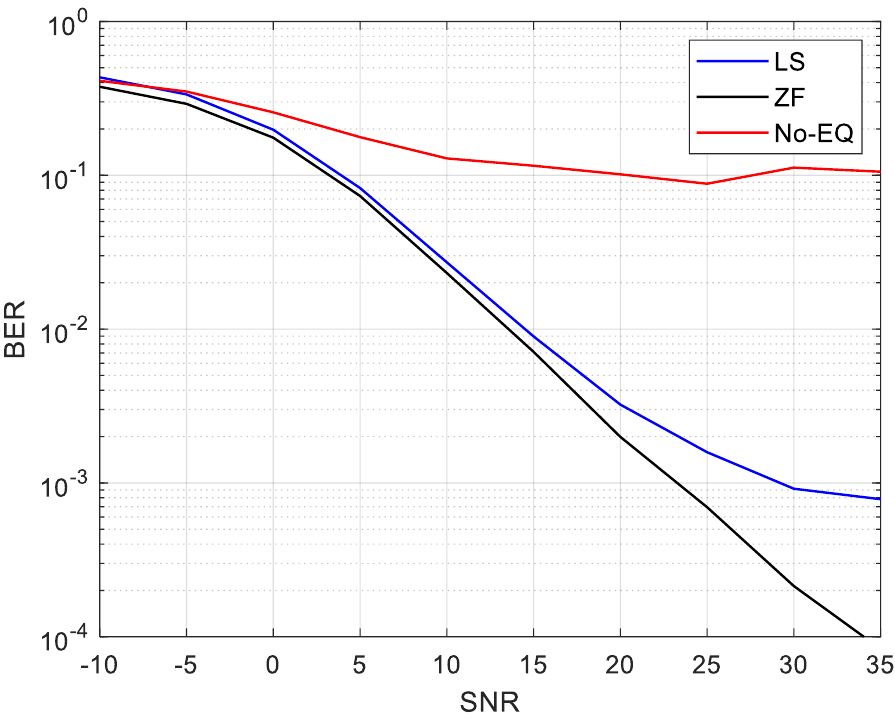
Figure 6. BER as a function of the equalizer used for QPSK CP-OFDM with 128 subcarriers, a transmitter-receiver distance of 800 m, and the number of pilots as 32.